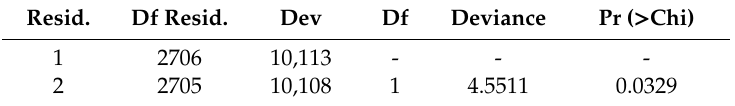
Table 24. Comparison of the variables camera rotation and device used by ANOVA.